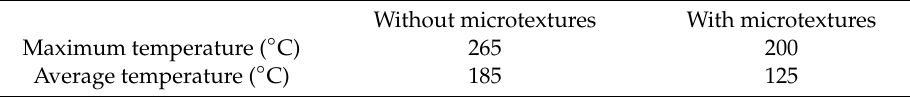
Table 9. Temperature results of the cylinder without and with microtextures.